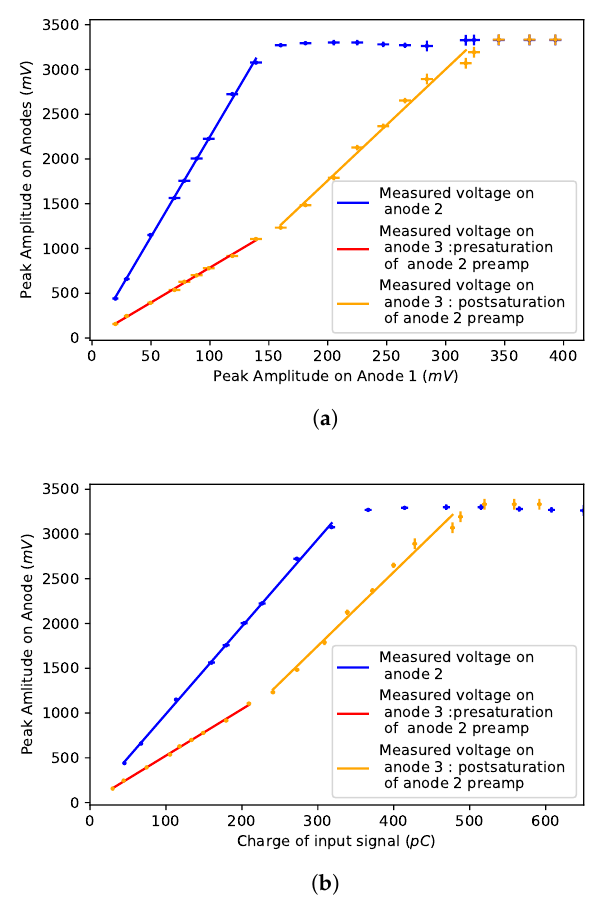
Figure 19. Peak height ( V amp ) measured by the anode 2 and anode 3 readout channel (with pre- output amplifier) for test pulses injected into the amplification region via the anode 1 mesh. Both plots show the same data with different units on the horizontal axis: ( a ) V amp as function of input test output pules signal height ( V input ) and ( b ) as a function of the charge seen at the pre-amplifier input. One polynomial of order ( P 1) one is fitted to the anode 2 (blue) measurement and two separate P 1s are fitted to the different regions on anode 3. One in the pre-saturation region of the anode 2 pre-amplifier (red) and one in the post-saturation region of anode 2 pre-amplifier (orange).